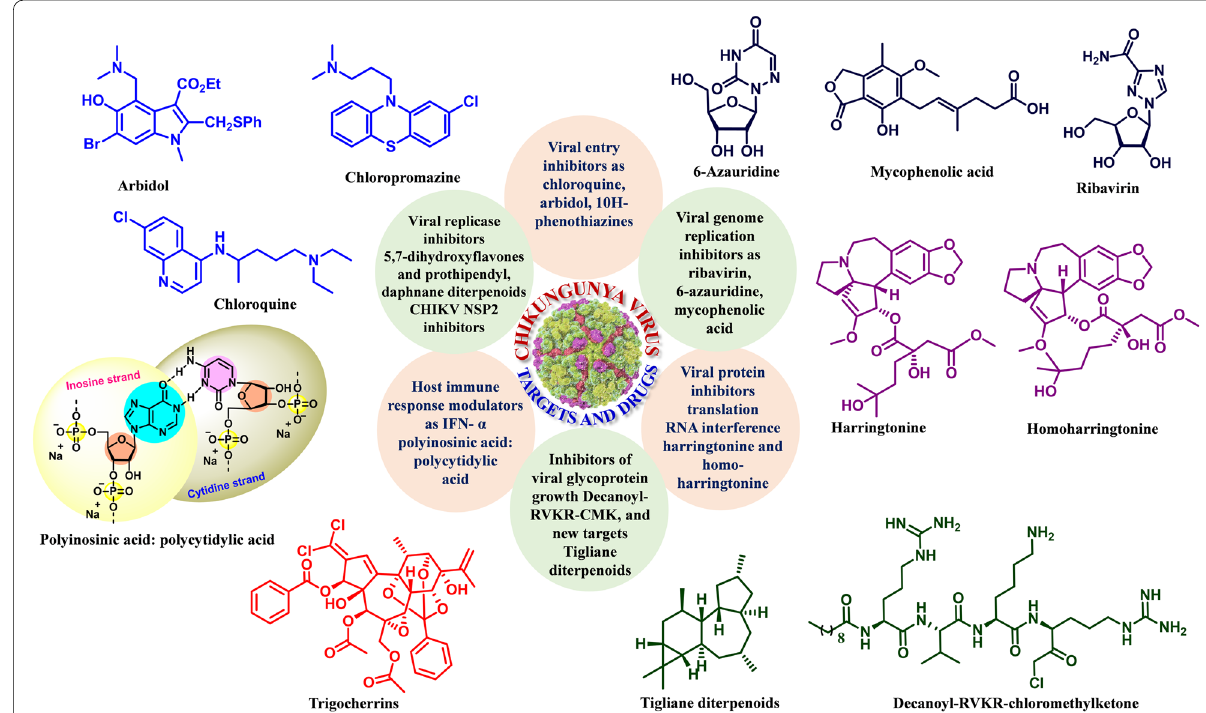
Fig. 3 Representative active targets and drugs against chickungunya virus such as Viral entry inhibitors as chloroquine, arbidol, 10H-phenothiazines; Viral genome replication inhibitors as Ribavirin, 6-Azauridine, mycophenolic acid; Viral protein inhibitors translation RNA interference harringtonine and homo-harringtonine; Inhibitors of viral glycoprotein growth decanoyl-RVKR-CMK, and new targets Tigliane diterpenoids; Host immune response modulators as IFN- α polyinosinic acid: polycytidylic acid; Viral replicase inhibitors 5,7-dihydroxyflavones and prothipendyl, daphnanediterpenoids, CHIKV nsP2